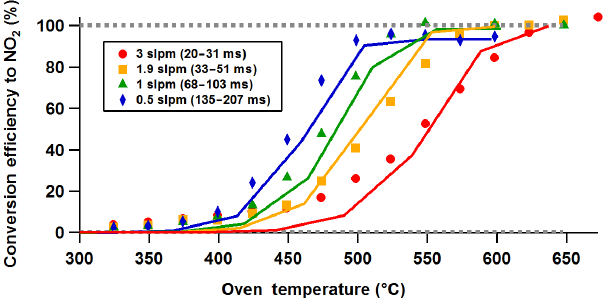
Figure 2. HNO 3 thermograms measured at several flow rates in the NOAA TD-CRDS. Conversion efficiency is calculated as measured NO 2 signal relative to the expected concentration of HNO 3 . Paren- theses in the legend indicate the range of residence times experi- enced by the sample in the heated inlet. The grey dashed lines indi- cate 0 and 100% conversion. Solid lines show simulations using a simple kinetic box model, as described in the